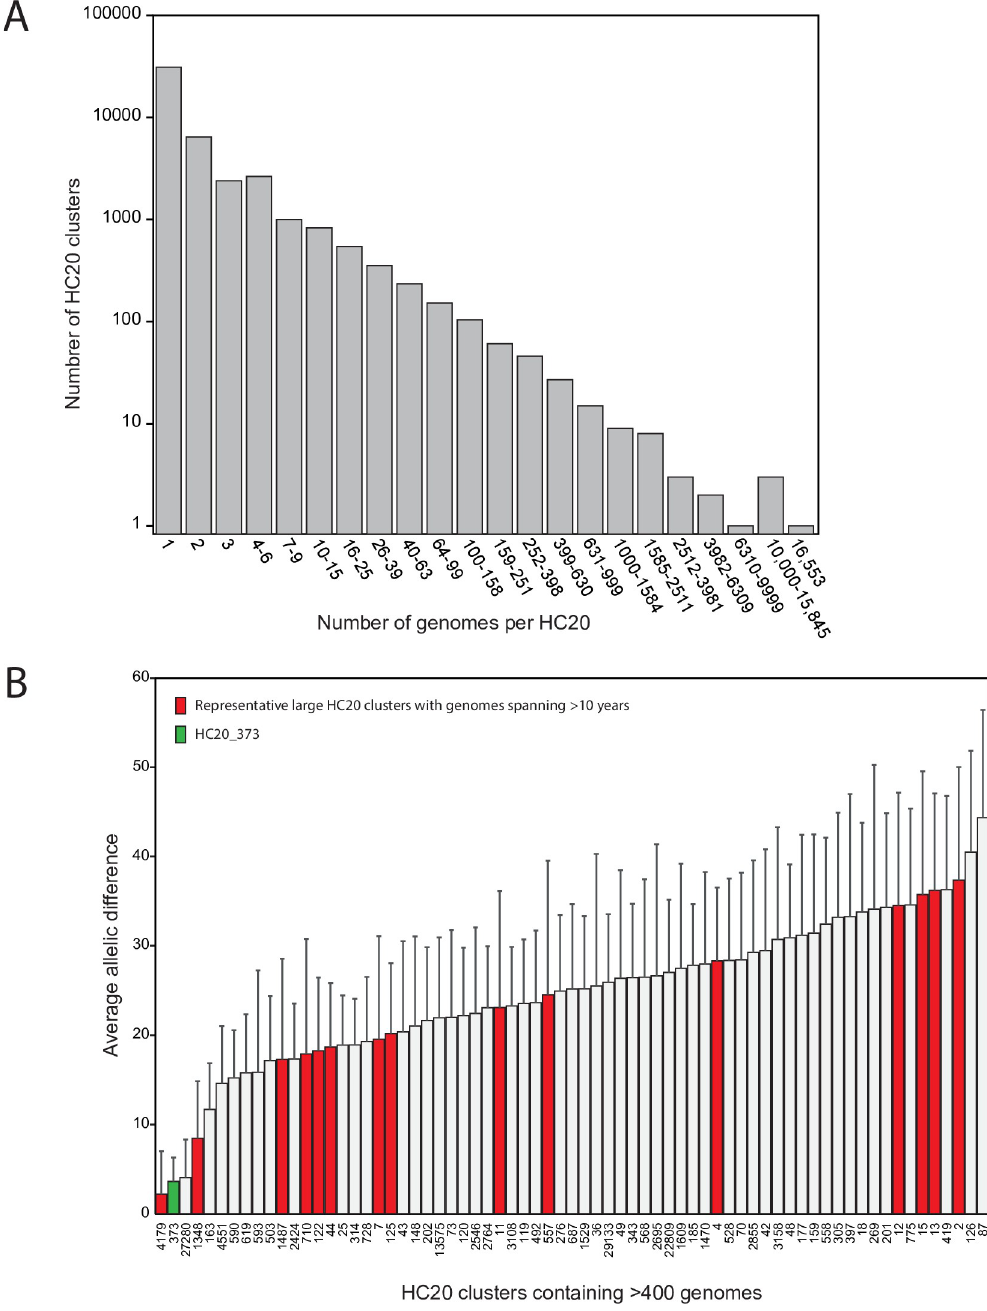
Fig 5. Properties of HC20 clusters among > 300,000 assembled genomes within the Salmonella database within EnteroBase (June, 2021). A) Numbers of HC20 clusters vs numbers of genomes per cluster. B) Average pairwise allelic differences between genomes in HC20 clusters containing at least 400 genomes. Red indicates selected HC20 clusters whose properties are summarized in Tables 2 and S4. NJ trees of allelic distances can be found in S4–S9 Figs. HC20_373 is highlighted in